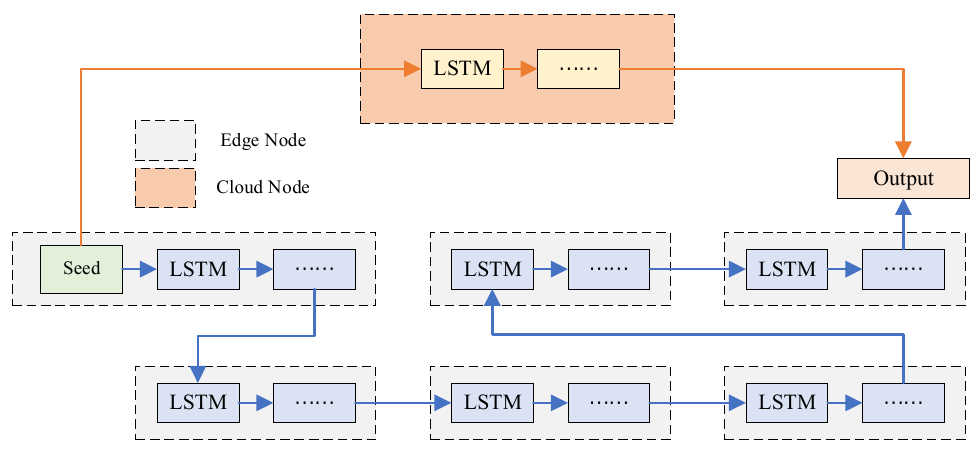
Figure 14. R-AIBot experimental network.